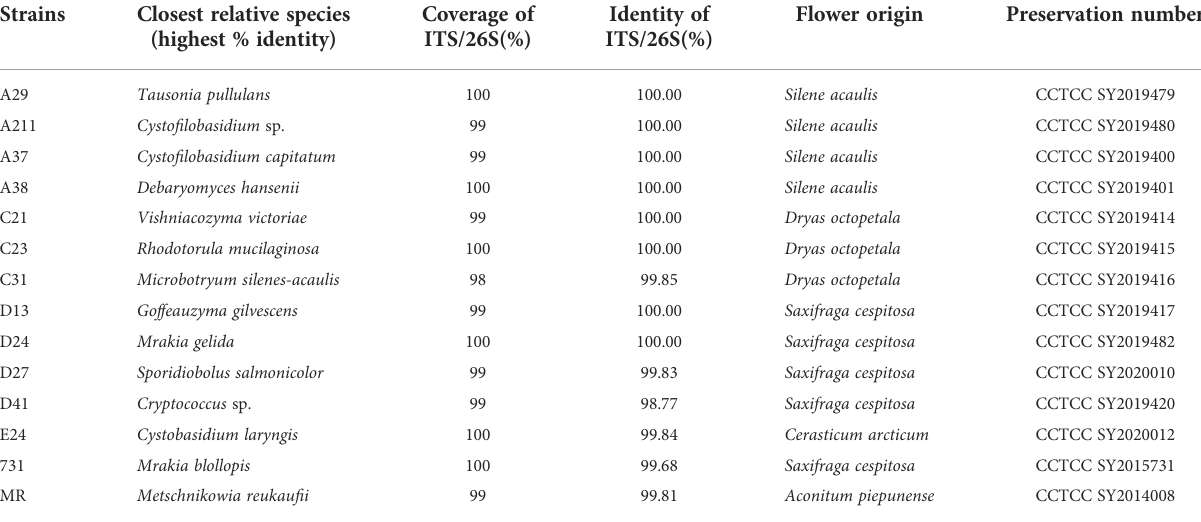
TABLE 1 Detailed information about selected yeasts. Strains Closest relative species (highest %